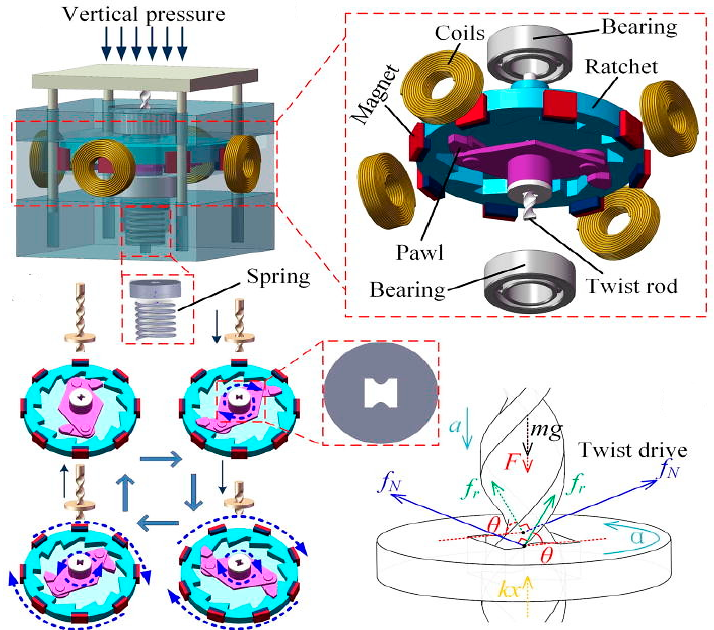
Figure 22. 3D model of the rotational electromagnetic harvester installed in the smart tile [57].